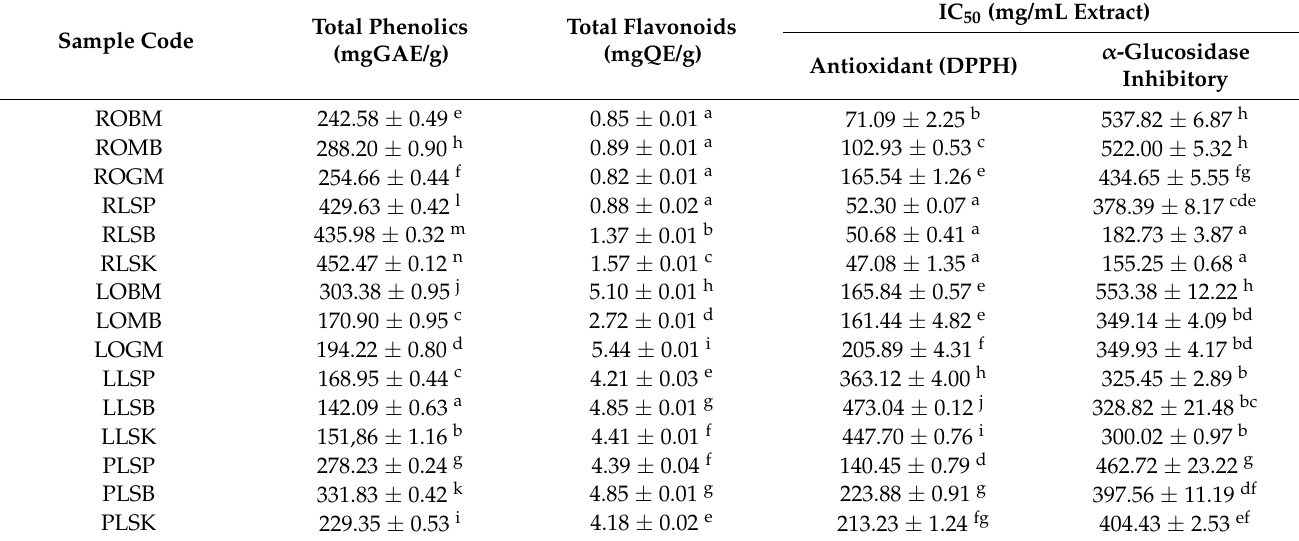
Table 2. Total phenolics, total flavonoids, antioxidant, and α -glucosidase inhibitory activities in 70% ethanol extract of C. orchioides and C. latifolia